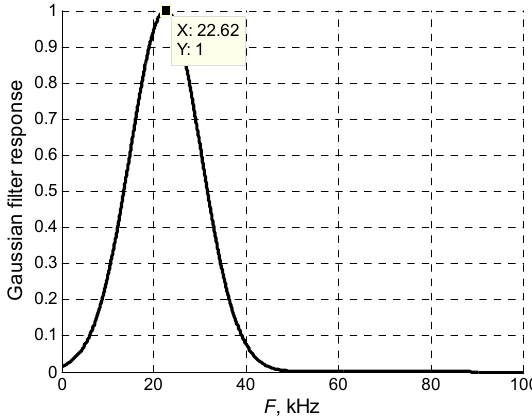
Figure 9. Frequency response of the Gaussian filter.